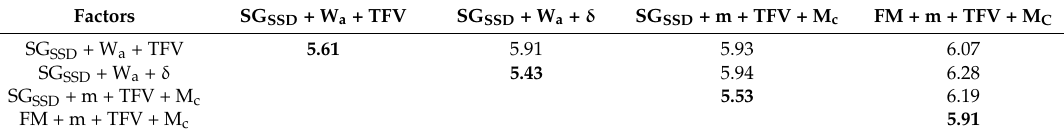
Table 7. The errors of networks for compressive strength with different input variables—Stage d (%). Factors